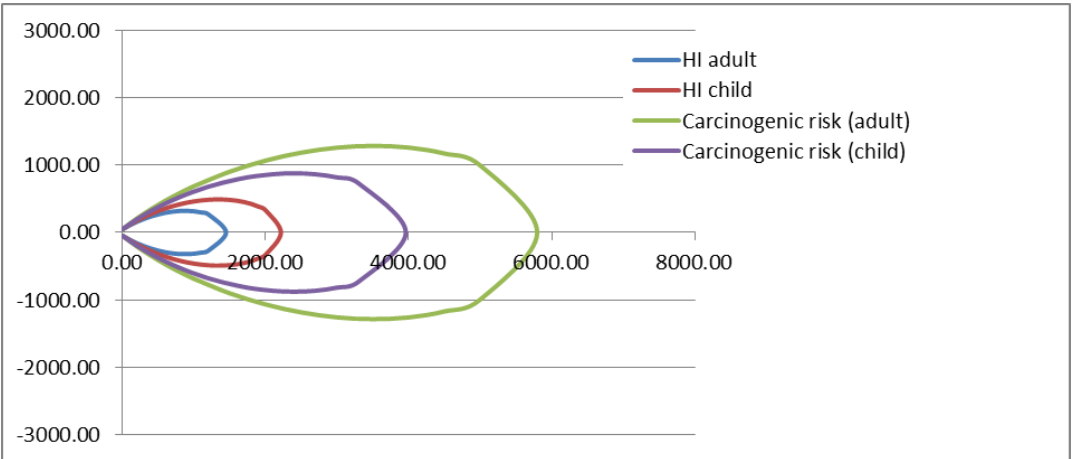
Figure 1. Estimated area of risk with regard to both carcinogenic and toxic (not carcinogenic) contaminants. The values along the axes are expressed in meters.